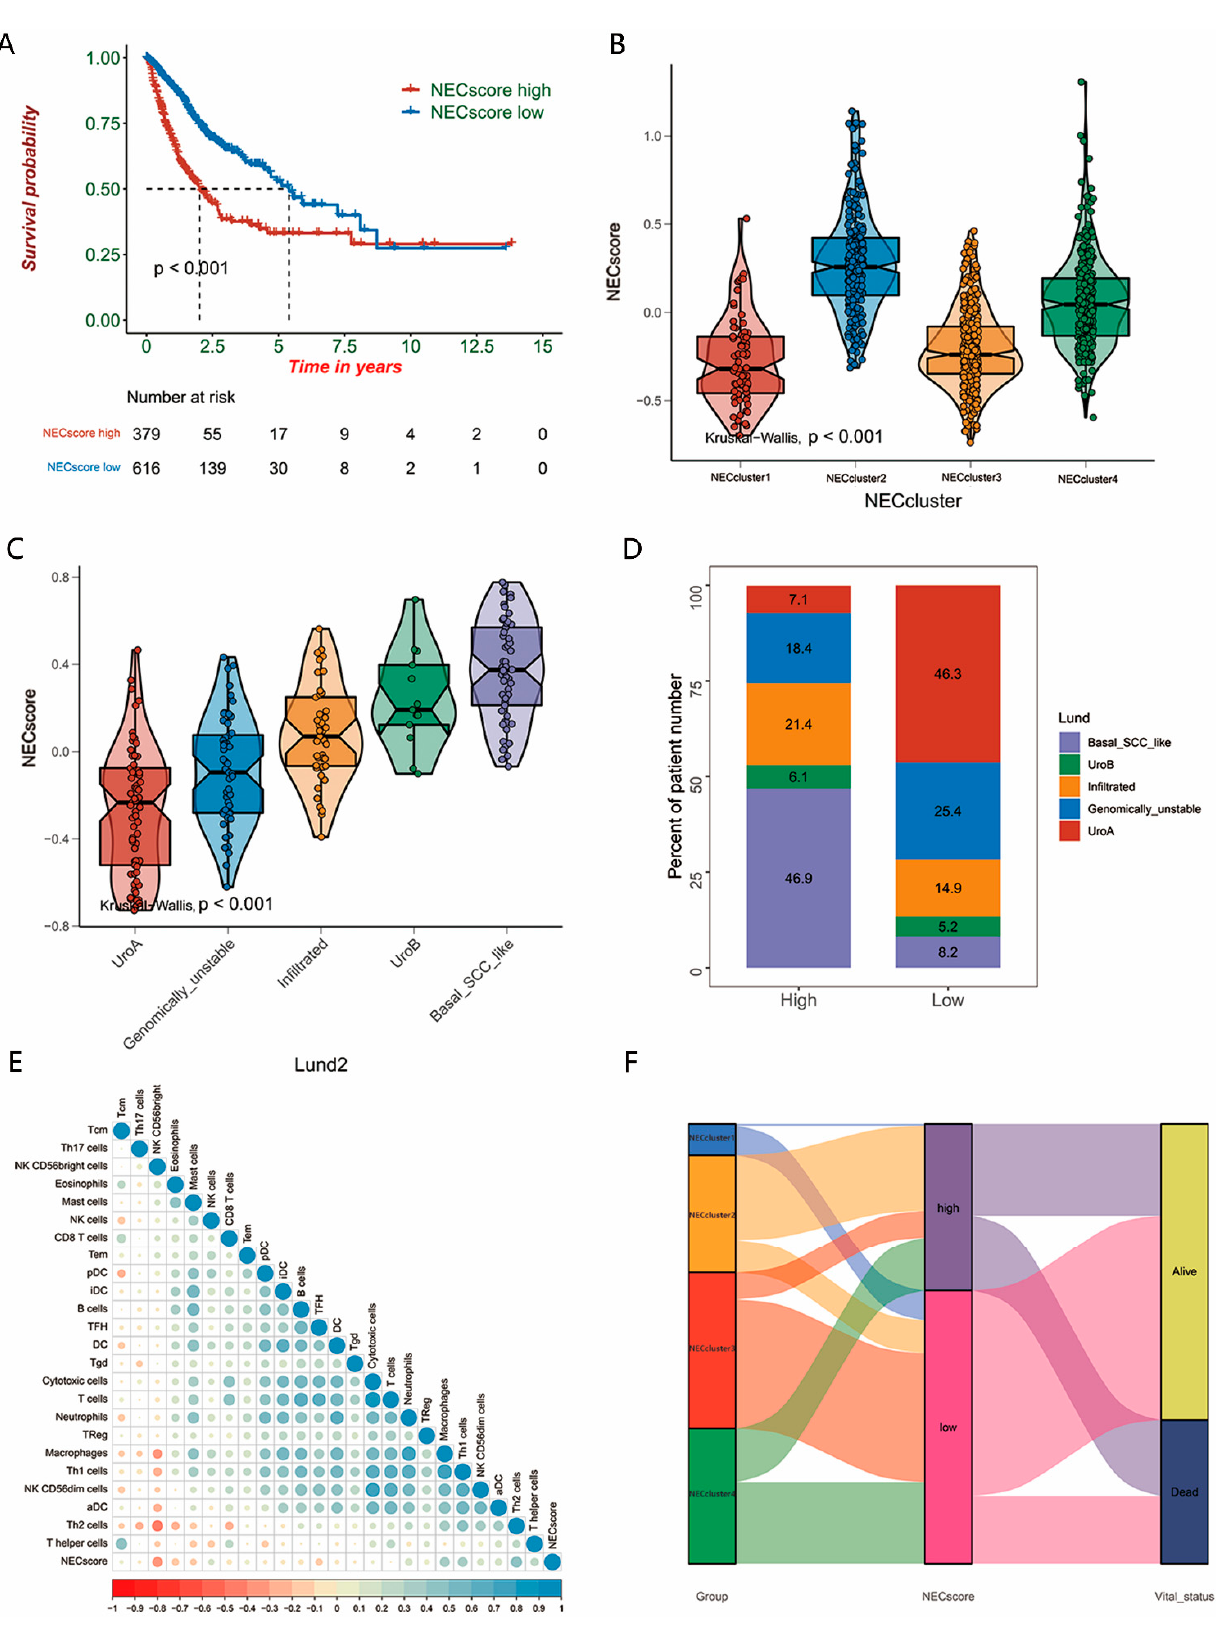
Figure 3. Transcriptome traits and biological characteristics of necroptosis-related gene signature (NEC score) in meta-BLCA cohort ( A ) Kaplan–Meier survival curves showed the difference in prognosis advantage between high and low NEC score groups in meta-BLCA cohort (log-rank